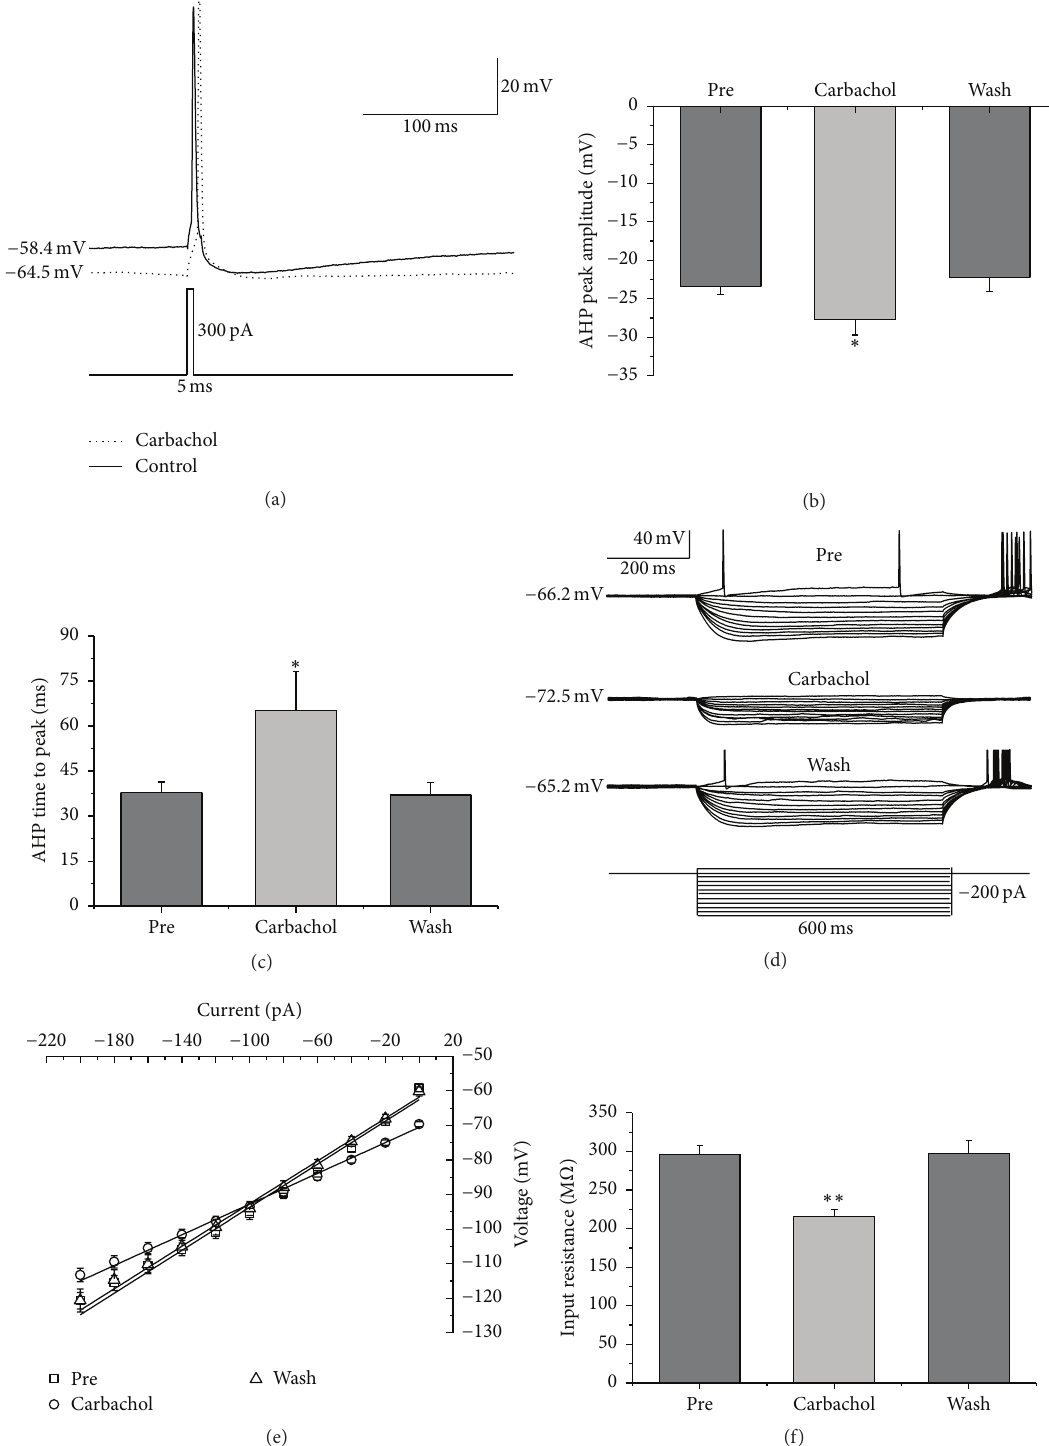
Figure 4: Effects of 30 𝜇 M carbachol on the intrinsic properties of RA projection neurons. (a) Representative AP recordings in response to a depolarizing pulse before and during carbachol application. (b) AHP peak amplitude was significantly increased in the presence of carbachol ( 𝑛 = 19 ). (c) AHP time to peak was significantly increased in the presence of carbachol ( 𝑛 = 19 ). (d) Voltage responses of a neuron to a series of hyperpolarizing current steps before, during, and after carbachol application. (e) The current-voltage curves showed that there was a significant change in the slope by carbachol application ( 𝑛 = 34 ), indicating carbachol had an effect on membrane input resistance. (f) Membrane input resistance was significantly decreased in the presence of carbachol ( 𝑛 = 34 ). ∗ means 𝑝 < 0.05 , ∗∗ means 𝑝 < 0.01 , paired 𝑡